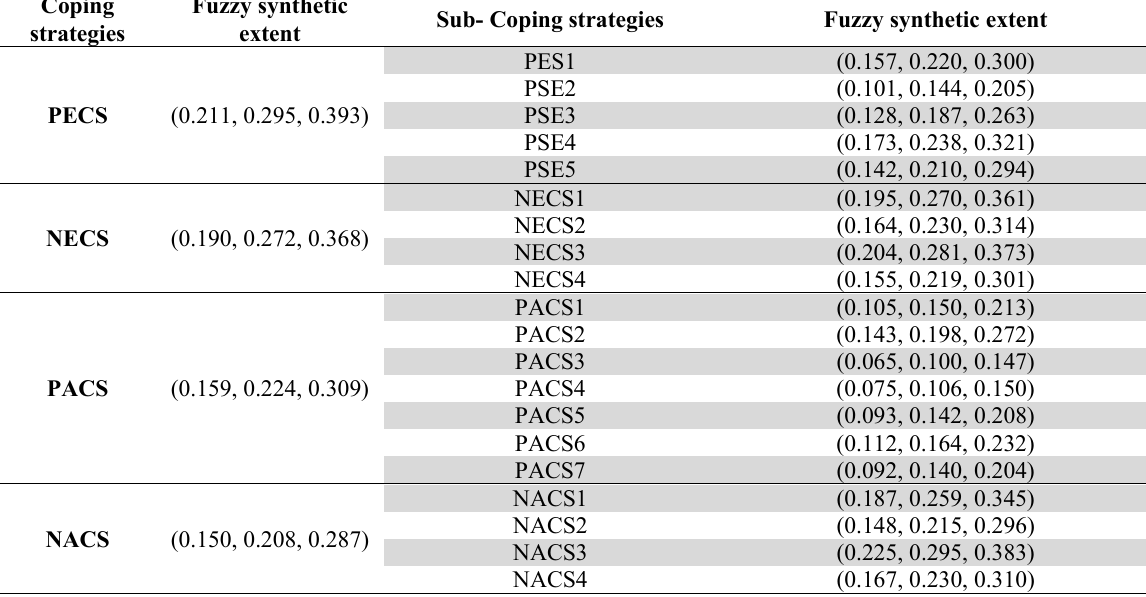
Fuzzy synthetic extent values of coping strategies and sub-coping strategies Coping Fuzzy strategies